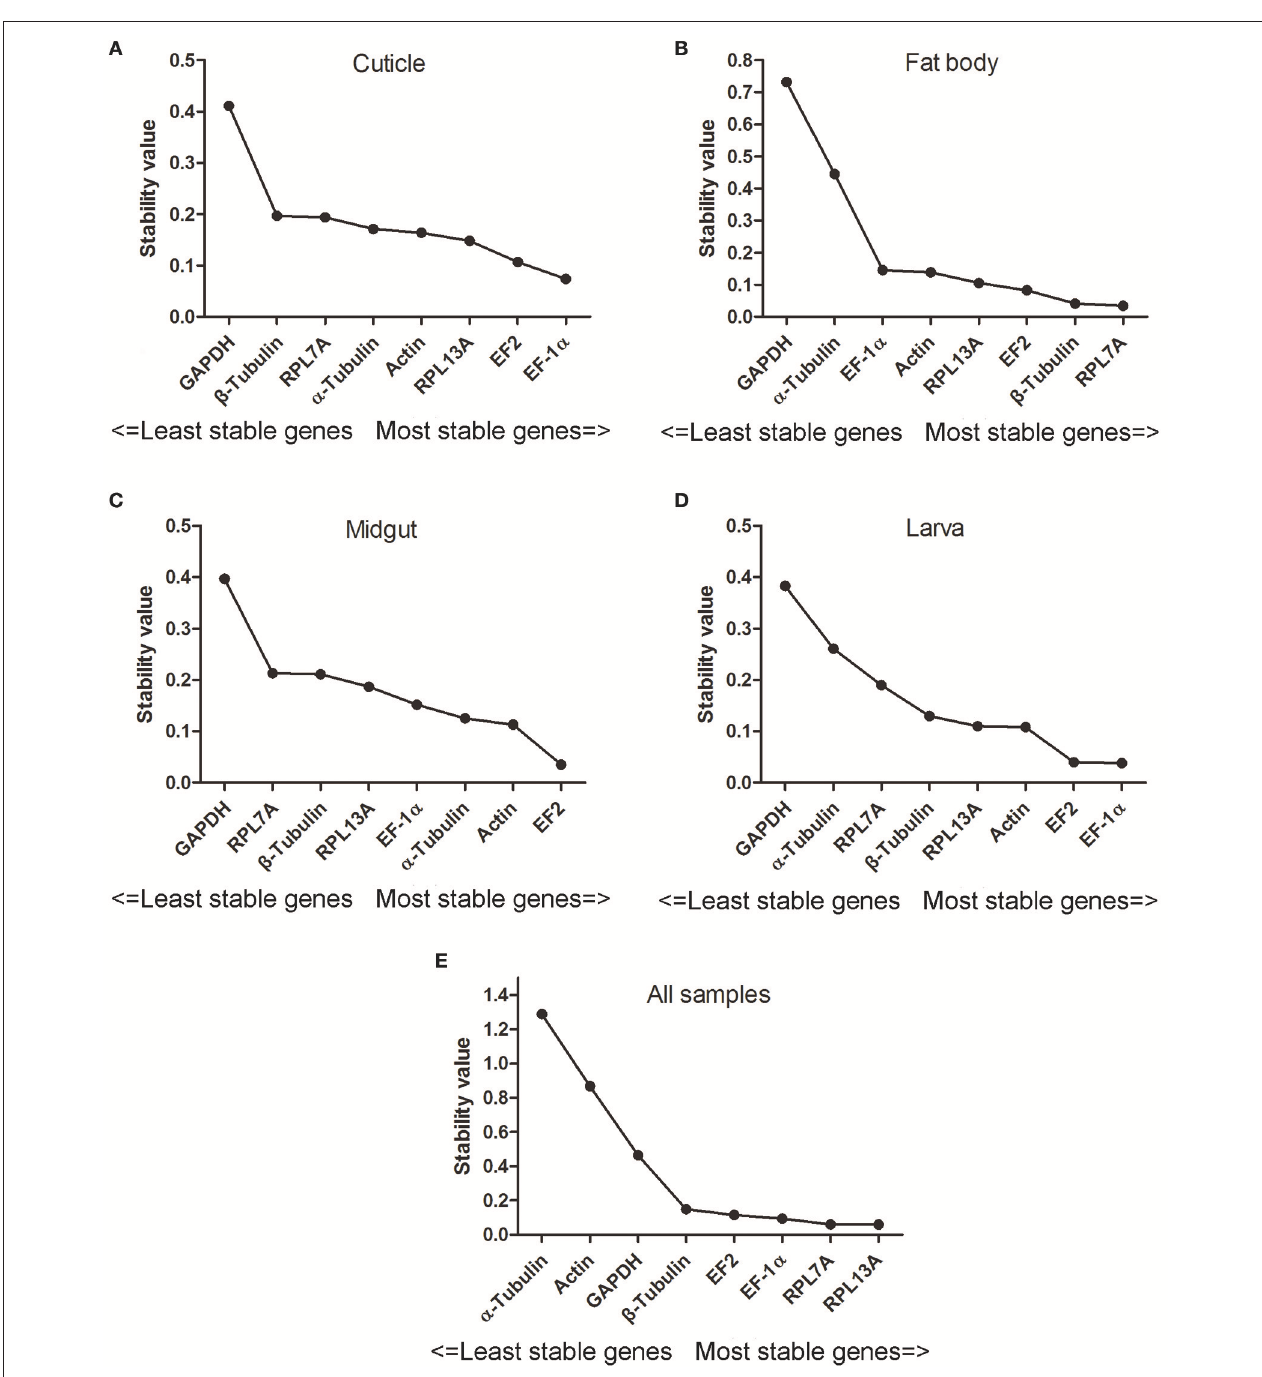
FIGURE 2 | The calculation of eight candidate reference genes expression stability by NormFinder. Abbreviations were showed as in Figure 1 . Panels (A–E) were represented as the stability validation results of reference genes expression in cuticle, fat body, midgut, larva, and all samples.